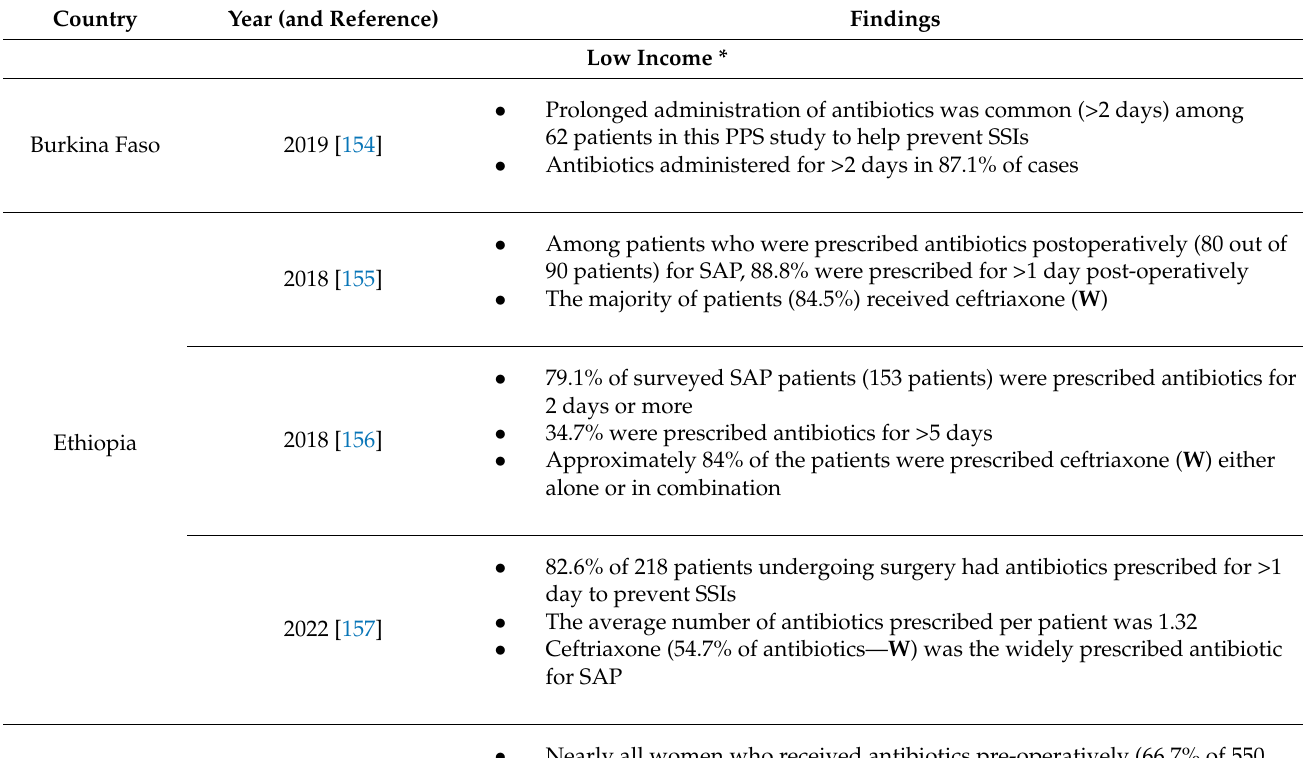
Table 1. Extent of prolonged antimicrobial prophylaxis to prevent SSIs across sub-Saharan Africa.